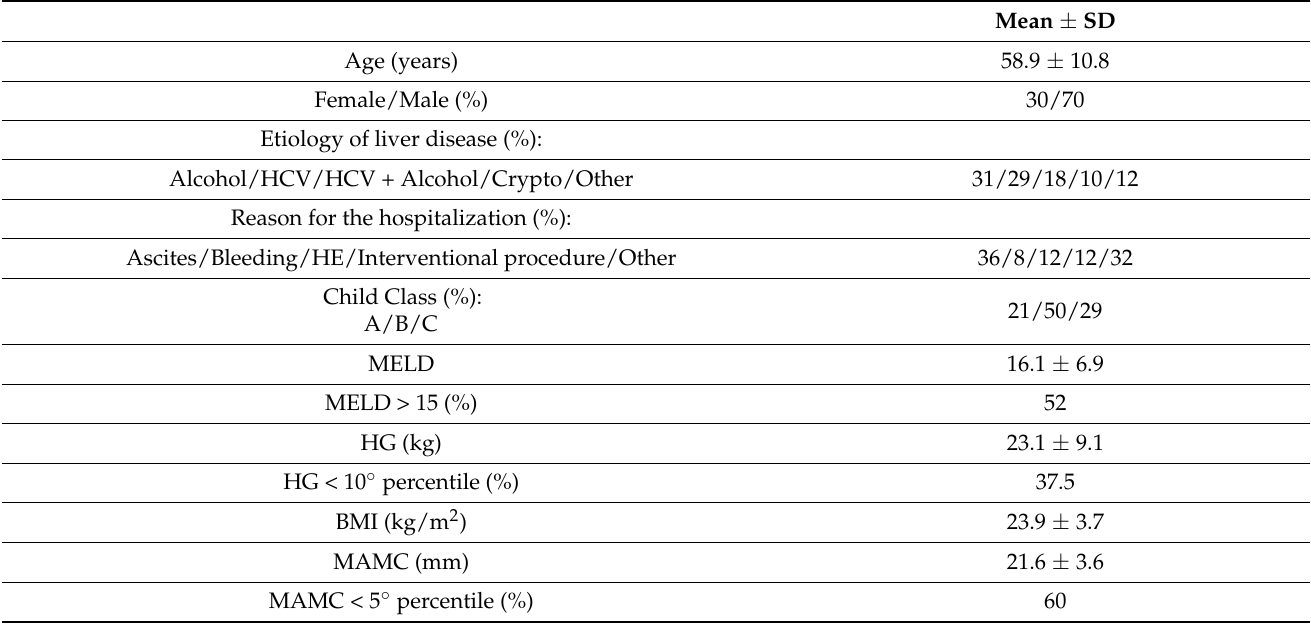
Table 1. General characteristics of the patients ( n =